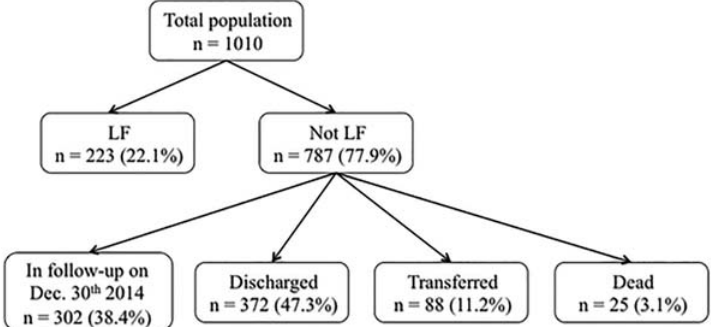
Figure 1. Outcomes of the study population. LF: lost to follow-up.